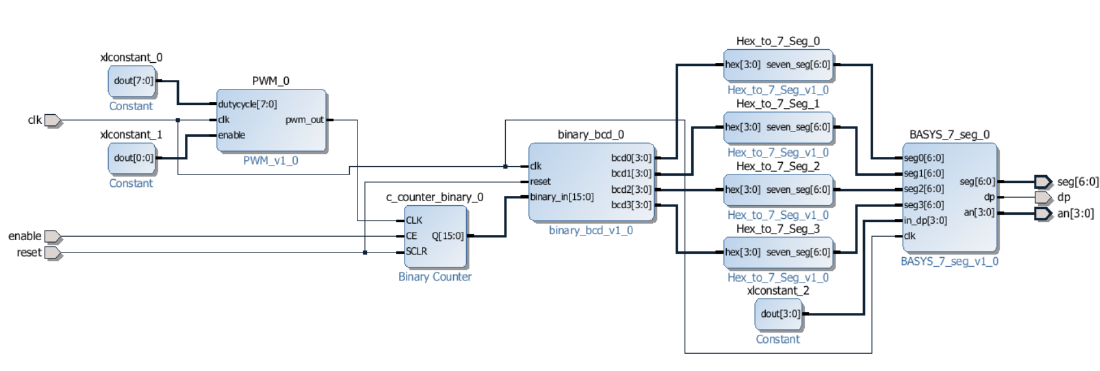
Figure 1. Configured IP Cores Block